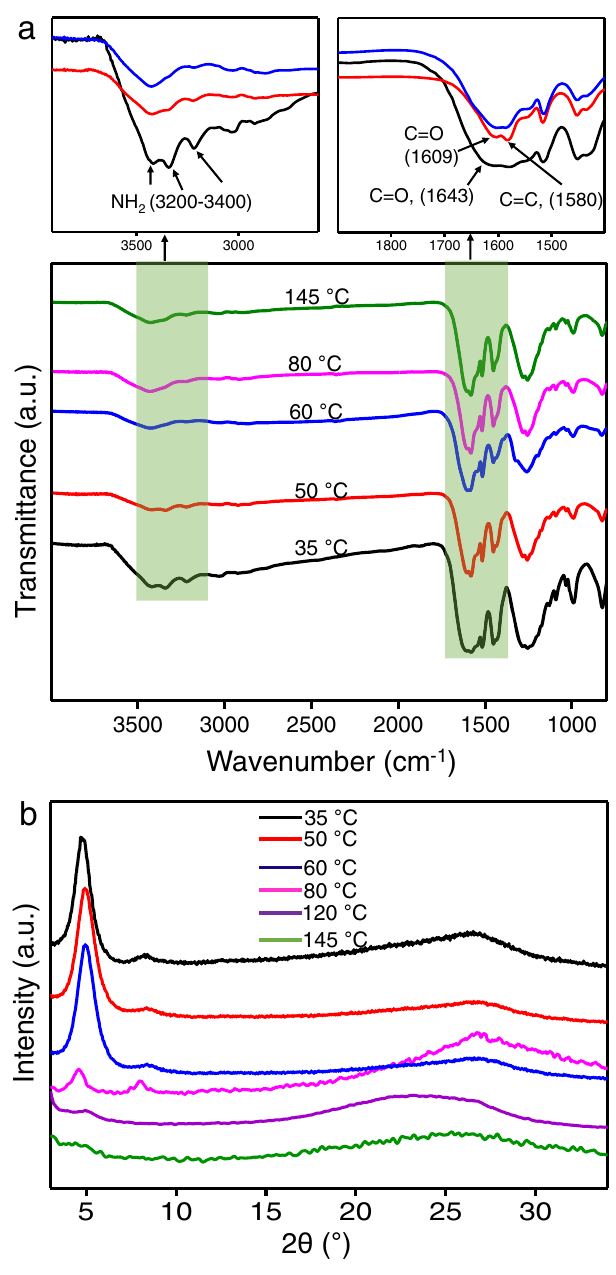
Fig. 3 Optimization of the temperature at pre-assembly step. a FT-IR of pristine membrane fabricated at various temperatures (35 – 145 °C). The disappearance of – NH 2 bands between 3200 and 3400 cm − 1 and the shift of C = O from 1643 to 1609 cm − 1 has been shown in the insets. b XRD of COF membranes (assembled at 145 °C) from TFP – PDA pristine membranes pre-assembled at various exhibited a rejection of 97.8% for OG compared with 79.3% by the TFP-PDA membrane.